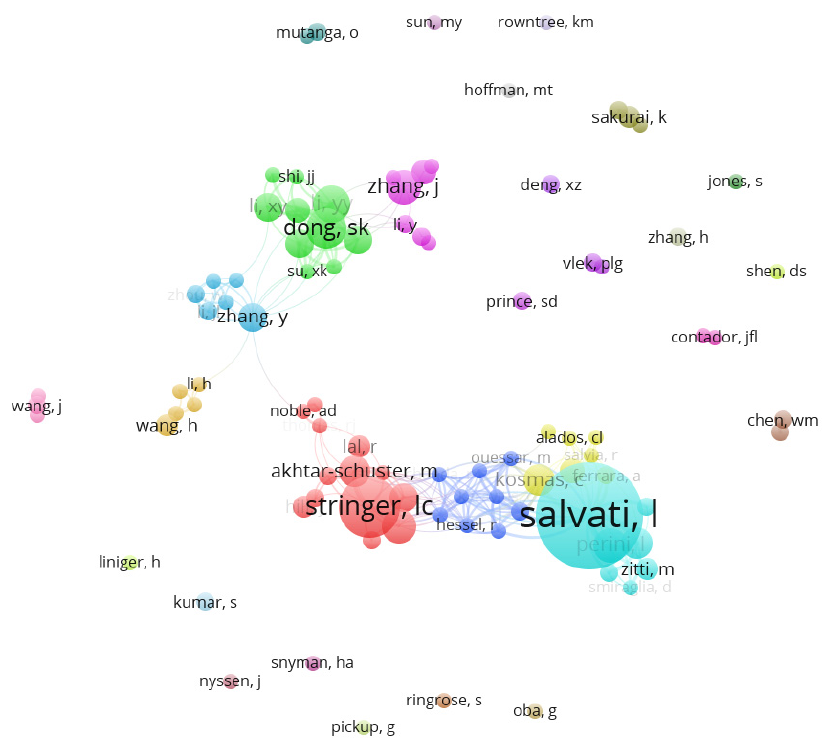
Figure 6. Collaboration map of authors in the field of land degradation.